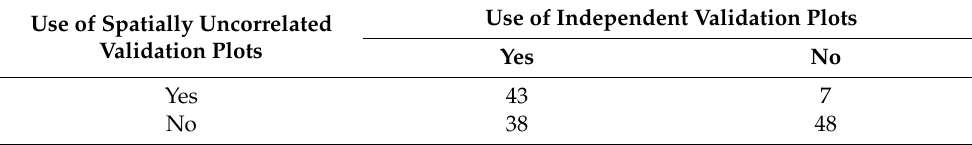
Table 9. Number of studies reviewed that used spatially uncorrelated and independent validation plots during the classification accuracy assessment. Use of Independent Validation Use of Spatially Uncorrelated Validation Plots